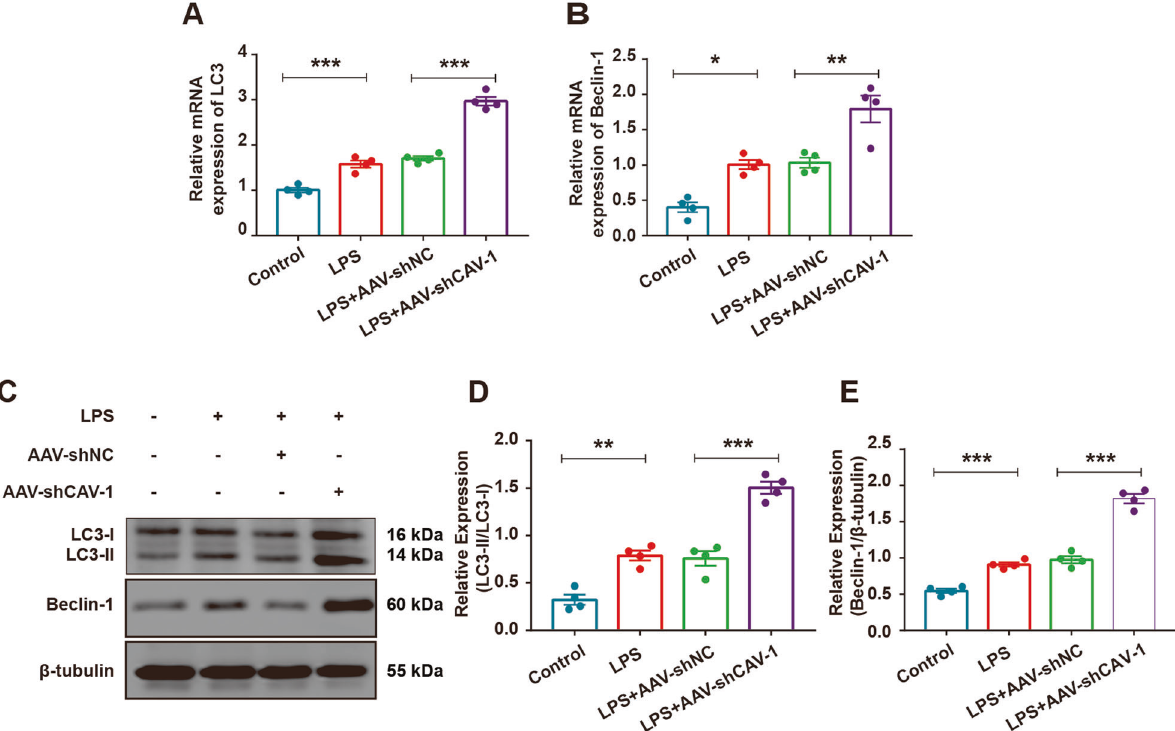
Fig. 4 Knocking down of CAV-1 improved autophagy and ameliorated ALI. A , B qRT-PCR demonstrated the mRNA levels of LC3 and Beclin- 1 in the lung tissues. C The protein levels of LC3II/I and Beclin-1 were examined by Western blotting in lung tissues. D , E Quanti fi cation of LC3 and Beclin-1 protein bands. Results were represented as mean ± SEM (n = 4, * p < 0.05, ** p < 0.01, *** p <